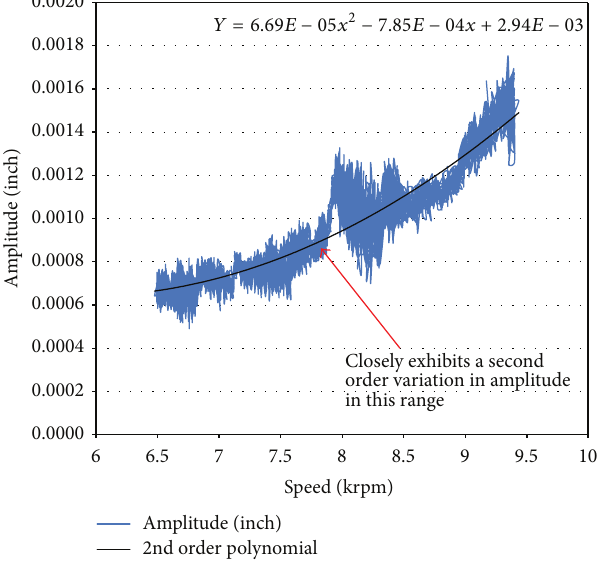
Figure 10: Detailed vibration amplitude plot for 10000rpm multiple-cycle